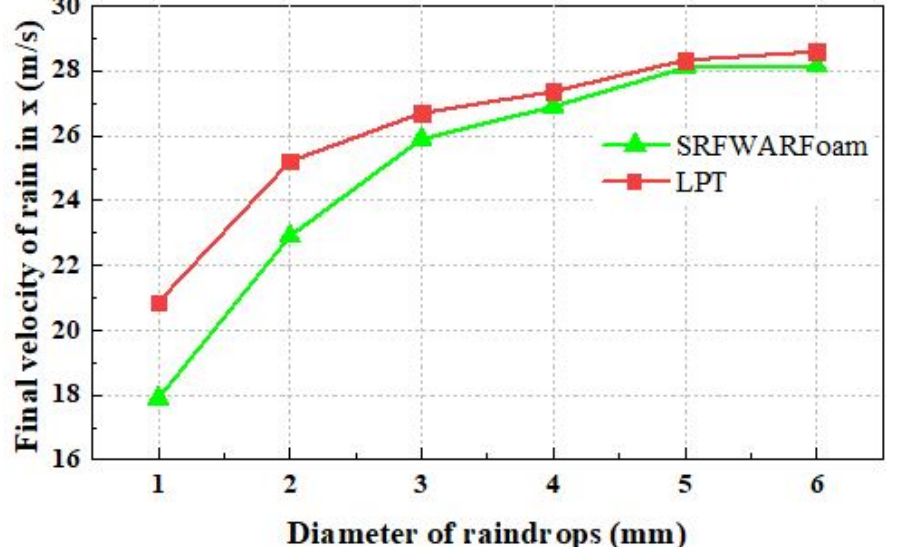
Figure 4. Horizontal end velocities of rain phases of different sizes .